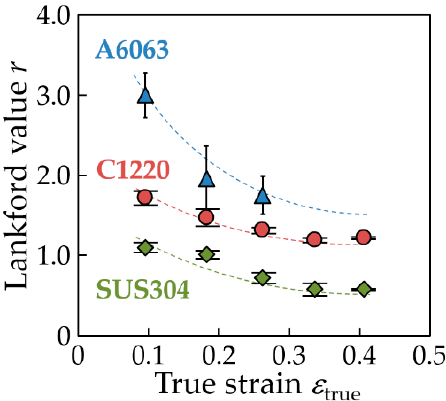
Figure 6. Lankford value against true strain obtained by the tensile test of each material. The dotted lines indicate the eye guide.